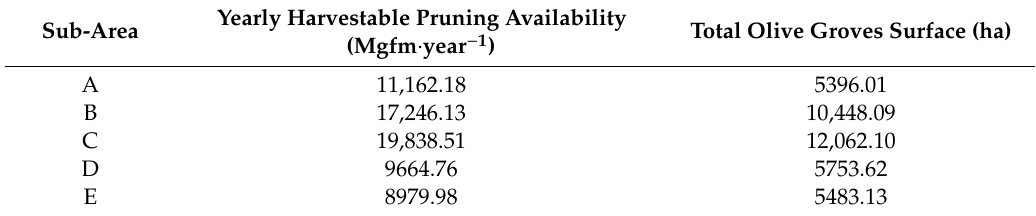
Table 2. Harvestable pruning yield and harvestable olive groves surface for each suitable